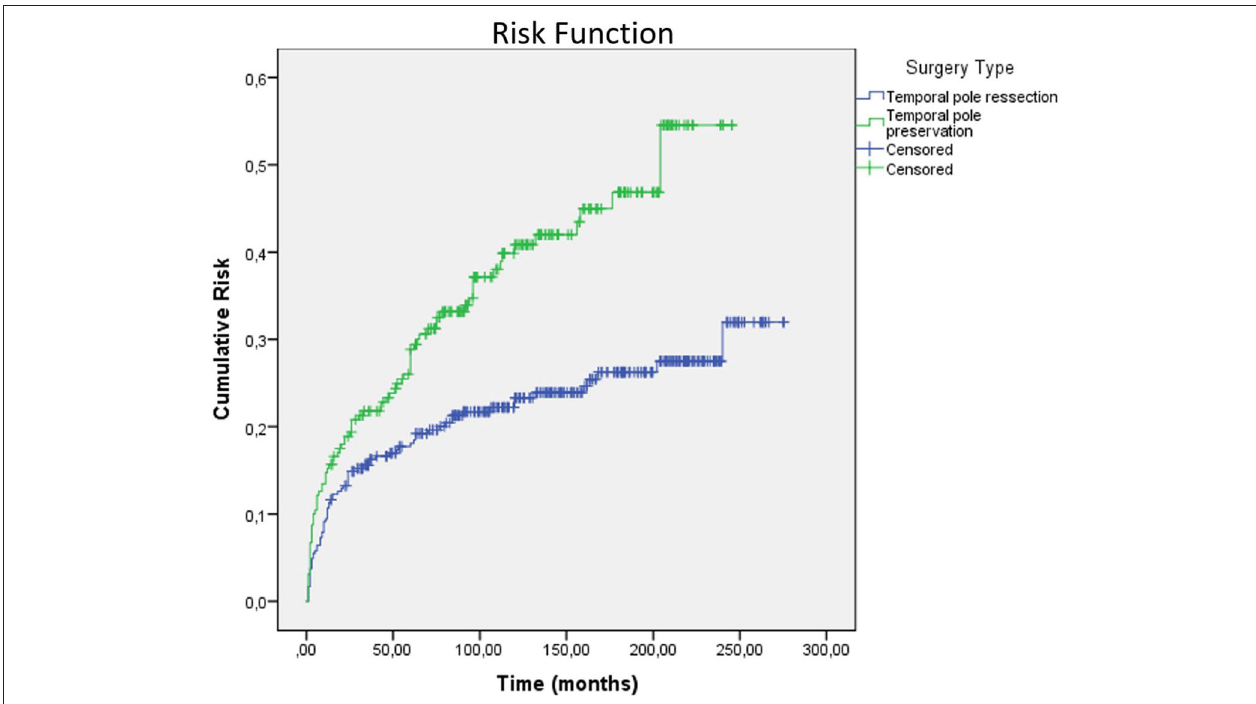
FIGURE 5 | Risk function according to the type of